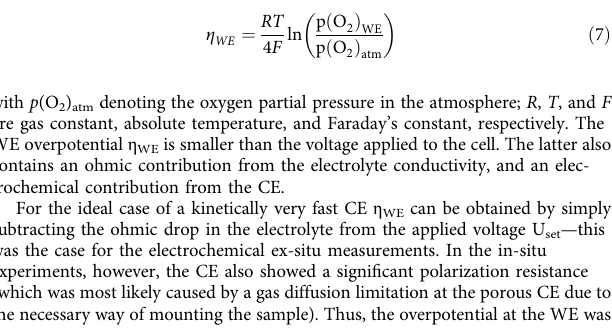
process, the Fe 0 particle size does not play a major role.